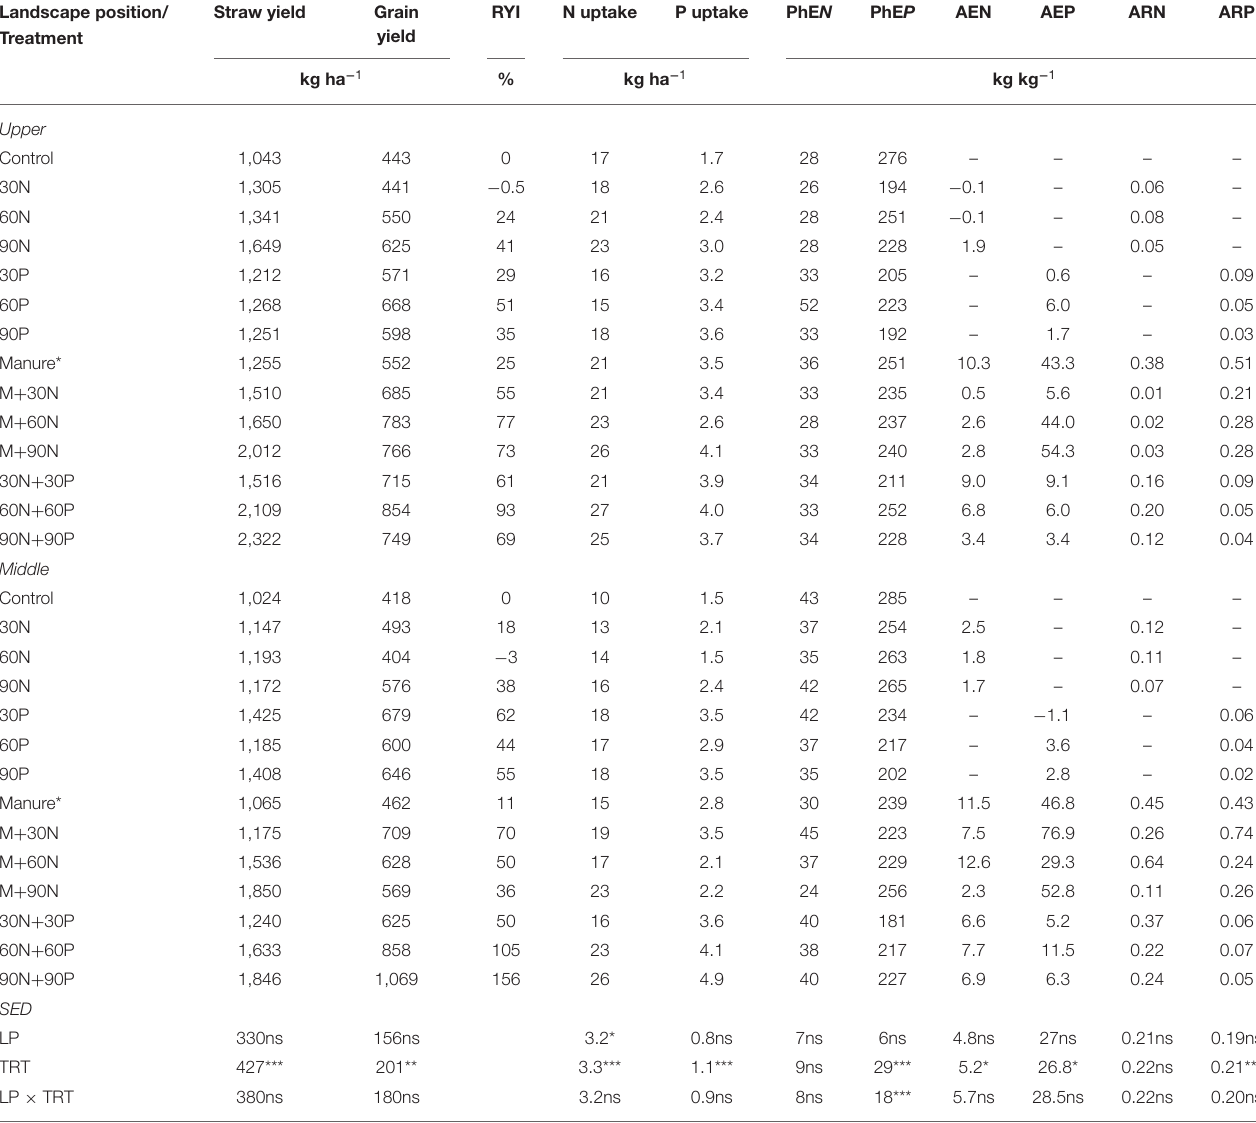
TABLE 3 | Average straw yield, grain yield, total nutrient uptake and internal nutrient use efficiencies, agronomic efficiencies, and recovery efficiencies of finger millet as affected by application of nutrient inputs to degraded fields on the upper and middle landscape positions in Chelekura village, 2 seasons of 2006. Landscape position/